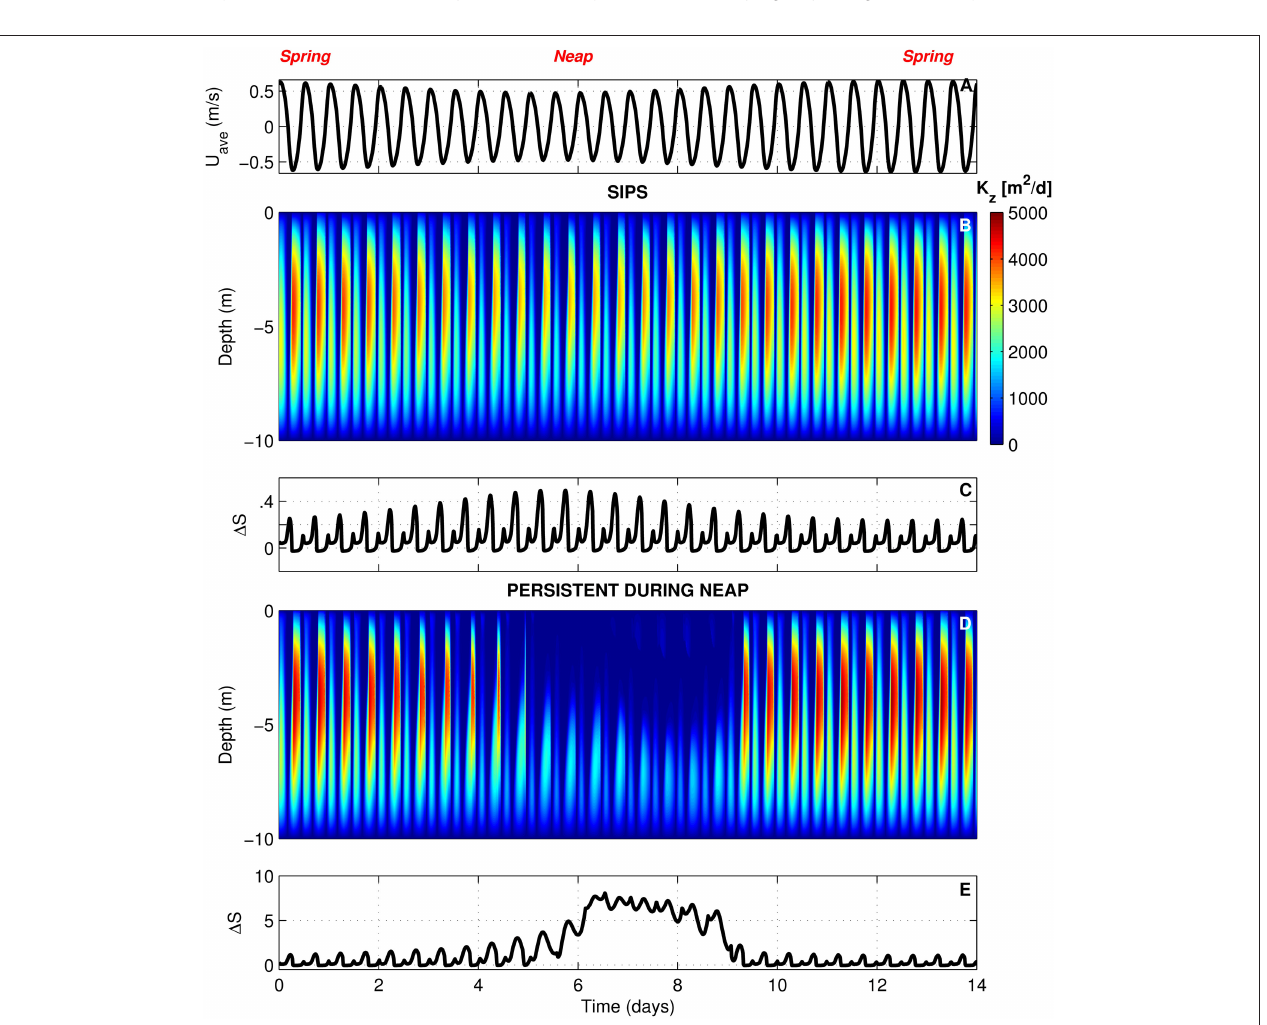
FIGURE 3 | BGO turbulence model outputs for generic channel. (A) Depth-averaged tidal velocity ( U ave ) for the SIPS case (similar to U ave for neap-tide stratification case). (B) Computed vertical turbulent diffusivities ( K ′ z s) across the vertical dimension and time for the SIPS case. (C) Vertical salinity difference (bottom minus top) for the SIPS case. (D,E) Same as (B,C), but for the case of persistent neap-tide stratification. Colorbar applies to both (B,D). See Table 3 for parameters implemented in modified BGO to generate these results.